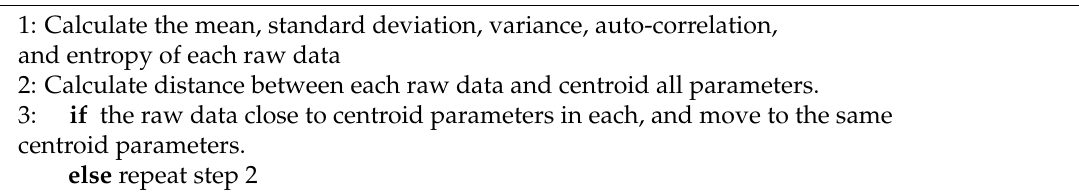
Algorithm 1 Pre-processing method